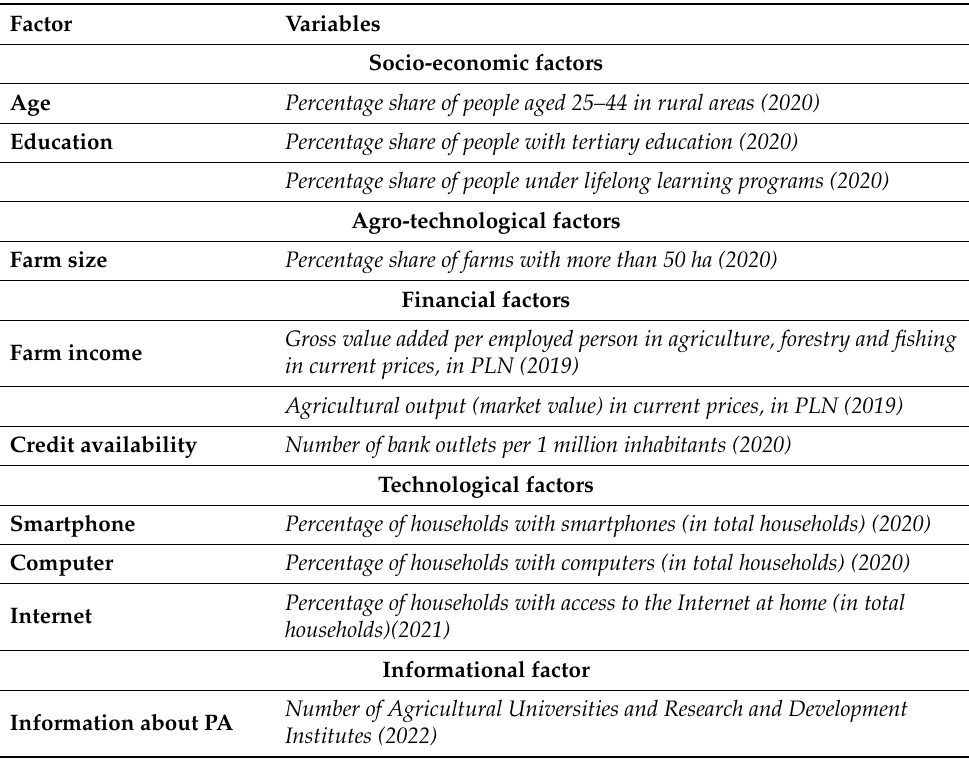
Table 2. PA adoption factors and their